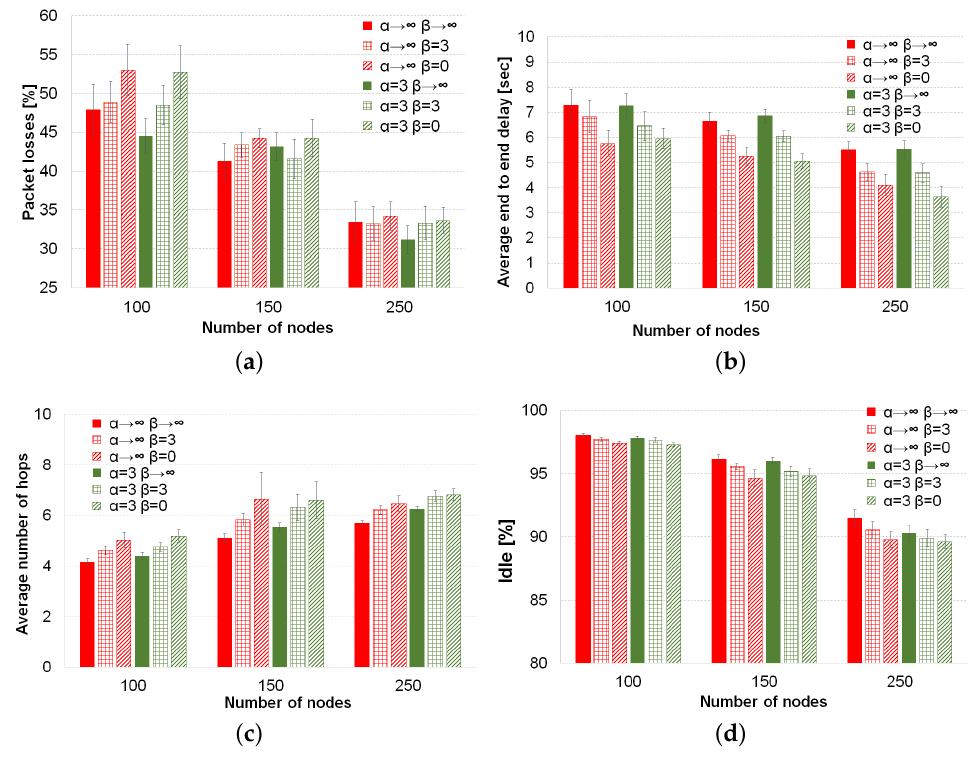
Figure 6. Performance evaluation of the recovery techniques ( RT ) included in our proposed GHR. The three RT are: carry and forwarding ( β → ∞ ), Simulated Annealing (SA) ( β = 3) and aggressive recovery ( β = 0). We compare them with two forwarding techniques ( FT ): best node selection ( α → ∞ ) and SA ( α = 3). ( a ) Percentage of packet losses; ( b ) average end-to-end packet delay; ( c ) average number of hops; ( d ) percentage of idle